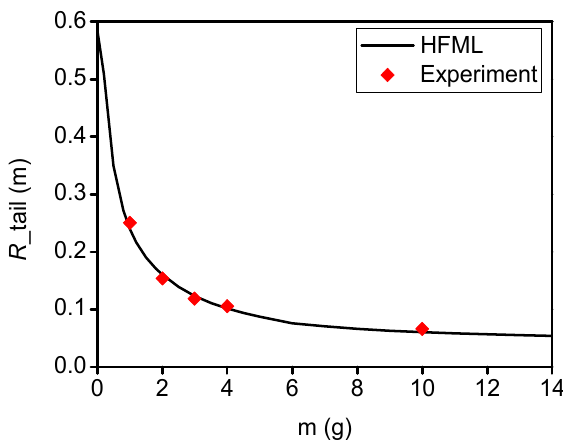
Figure 11. Curves of stable R _tail with different towed mass.